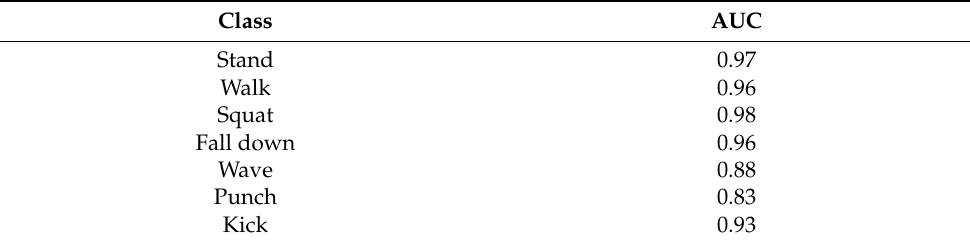
Figure 17. ROC curve of the model. Table 4. Optimal AUC of the